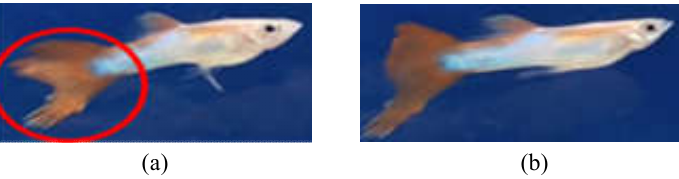
Figure 6. Features of rotten tail: ( a ) rotten tail is obvious and ( b ) rotten tail is not obvious.